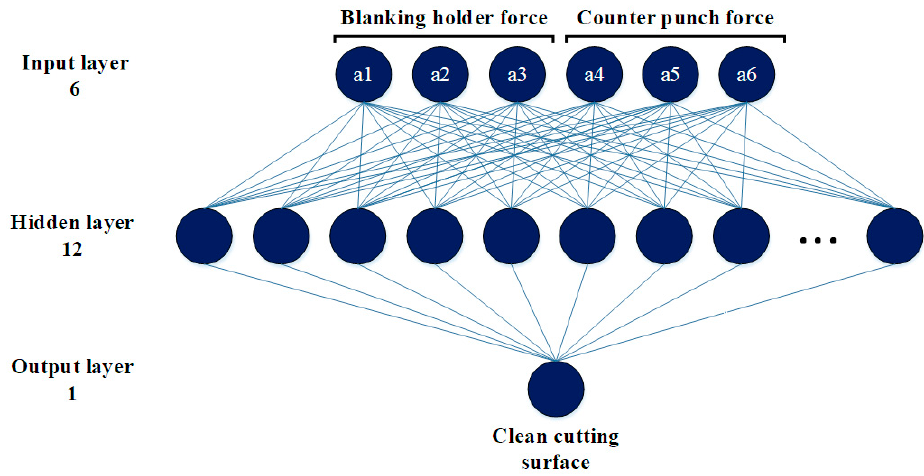
Figure 7. Neural network model structure of fine-blanking load process.